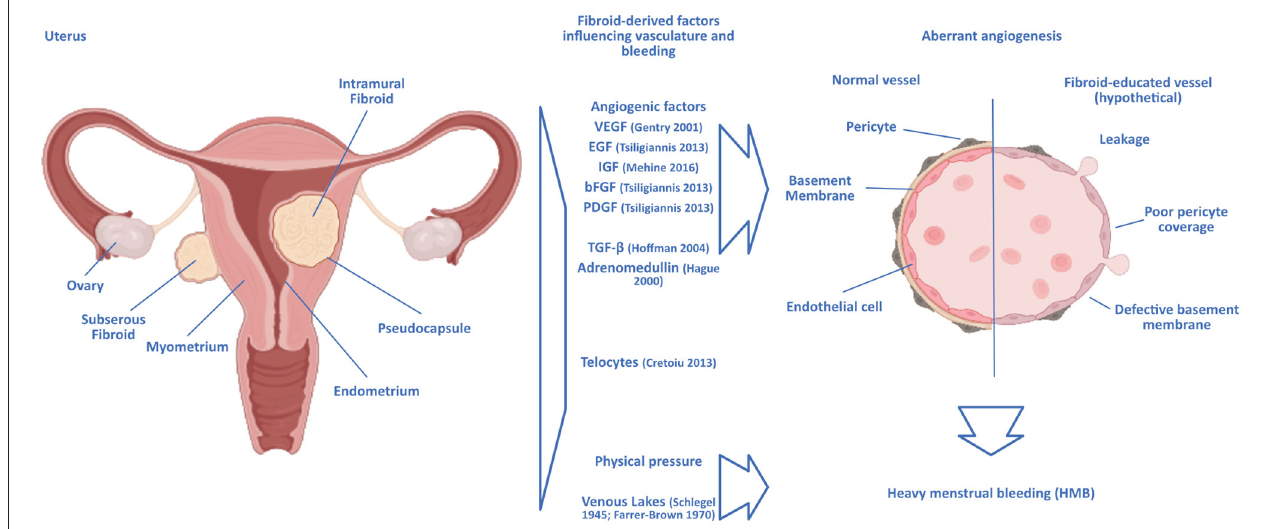
FIGURE 1 | Hypothetical scenarios of a link between uterine fibroids and heavy menstrual bleeding. Intramural uterine fibroids are surrounded by a pseudocapsule of vasculature supplying the growing tumor. The growth and presence of fibroids can lead to aberrant angiogenesis similar to that observed in malignant solid tumors, with the chaotic formation of blood vessels in the vicinity of the fibroids. The vasculature surrounding fibroids would then be structurally deficient, rendering it prone to breaking and leakage. Angiogenic factors identified as expressed by fibroids are displayed. Other hypotheses focus on the connection with the formation of enlarged venous lakes within the endometrium, presumably induced by the mere physical pressure exerted by the fibroids. Ultrastructural analysis of fibroid-educated vasculature would help unravel the actual mechanisms at